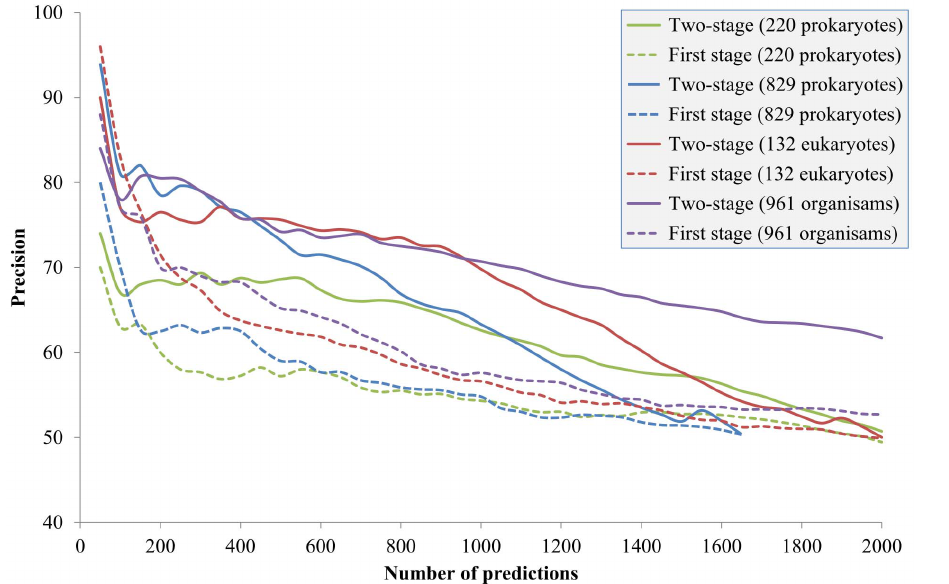
Figure 7.Performance using different reference collections. The y -axis is the ratio of correct predictions predicted in the top n predictions ( x - axis).